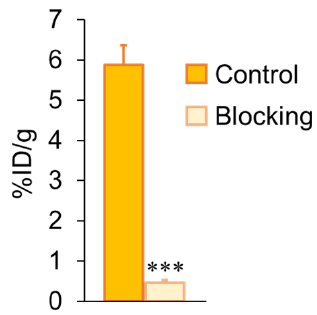
Figure 4. Blocking study. Comparison of tumor uptake (mean ± SD) of [ 125 I] 6 at 1 h postinjection under no-carrier-added conditions and with co-injection of an excess of c(RGDfK). Significance was determined by unpaired Student’s t -test (*** p < 0.001).